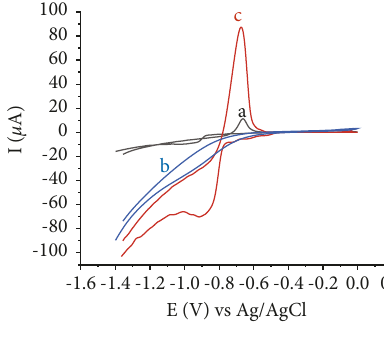
Figure 8: CVs of (a) unmodified CPE with accumulation of Cd(II), (b) HDPBA ‒ CPE without accumulation of Cd(II) and (c) HDPBA ‒ CPE with accumulation of Cd(II) in Britton Robinson (B-R) buffer (pH 4) at a potential of − 1.0V. Accumulation time: 270s; Cd(II) concentration: 100nM; scan rate: